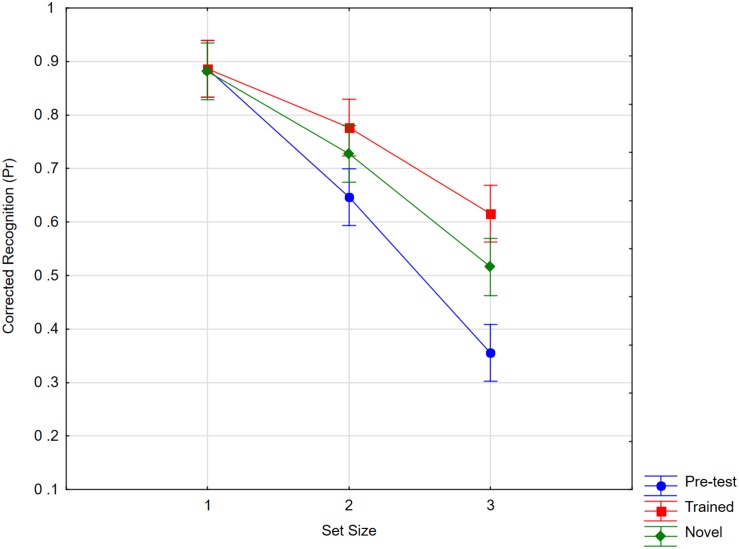
Recognition scores as a function of set size (1, 2, 3) and item status (pre-test, trained, novel). Whiskers show within subject confidence intervals based on the error term of the interaction according to Loftus and Masson (1994).